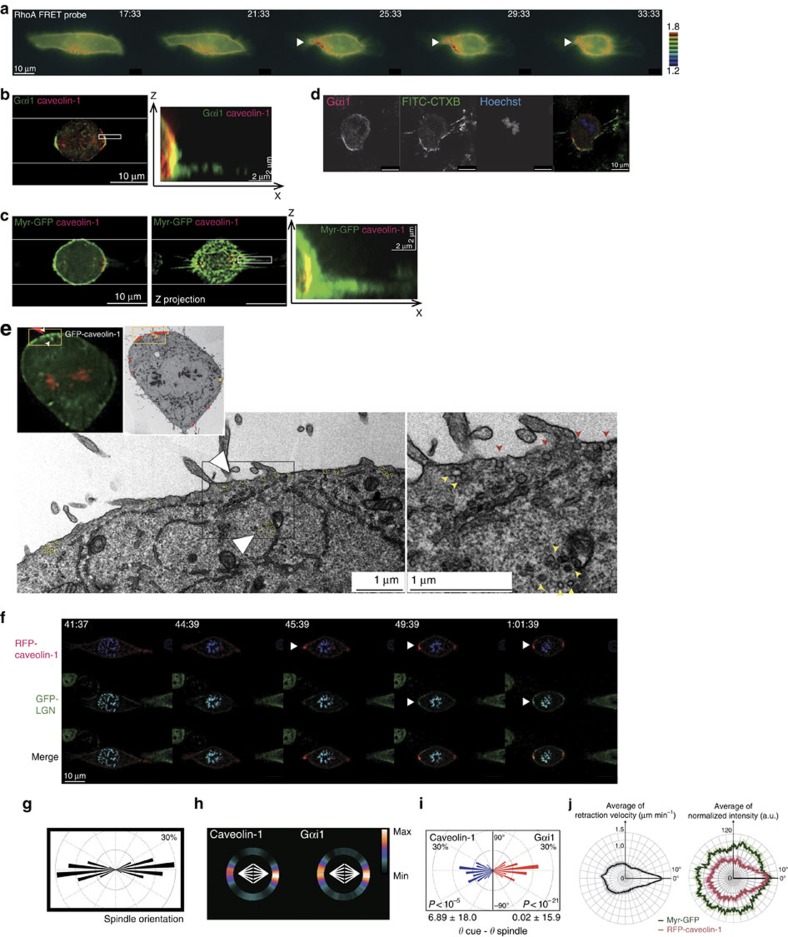
Caveolin-1 accumulates in the rapidly retracting cellular edge during mitotic cell rounding.(a) Time-lapse serial ratio images of the RhoA FRET probe expressed in HeLa cells cultured on a fibronectin-line micropattern. (b) Images of a metaphase cell cultured on the line micropattern stained with anti-Gαi1 (green) and anti-caveolin-1 (red) antibodies. A middle section of Z-stack images (left) and an X-Z projection image in the boxed area (right) are shown. (c) Images of a metaphase cell expressing MyrPalm-GFP (green) cultured on the line pattern stained with an anti-caveolin-1 antibody (red). A middle section of Z-stack images (left), a Z projection image (middle), and an X-Z projection image in the boxed area (right) are shown. (d) Images of a mitotic cell cultured on a fibronectin-coated coverslip and stained with an anti-Gαi1 antibody, FITC-labelled cholera toxin subunit B (CTX-FITC), and Hoechst. (e) Images of GFP-caveolin-1 fluorescence and electron microscopy. The boxed area is enlarged (middle and right). Red dots and arrowheads represent caveola-like structures, and yellow dots and arrowheads represent caveosome-like structures. (f) Time-lapse images of a mitotic cell expressing GFP-LGN (green), RFP-caveolin-1 (red) and CFP-histone H1 (blue) on the line micropattern. Arrowheads indicate the recruitment of fluorescent proteins at the retracting cortical region. (g) Angular distributions of the spindle orientation along the long axis of the line pattern. (h) The distribution of cortical caveolin-1 or Gαi1 signals against the spindle axis (white). The colour-code indicates the average of the relative intensity at each angle. (i) Distribution of the angle difference between the spindle angle and predicted spindle orientation based on the cortical intensity of caveolin-1 or Gαi1. P values represent the probability against random prediction (within 30°). Mean±s.d. (below). (j) Distribution of retraction velocity per angle (left) and distribution of values per angle at the cellular edge (right). For details, see Supplementary Figs 3 and 4.